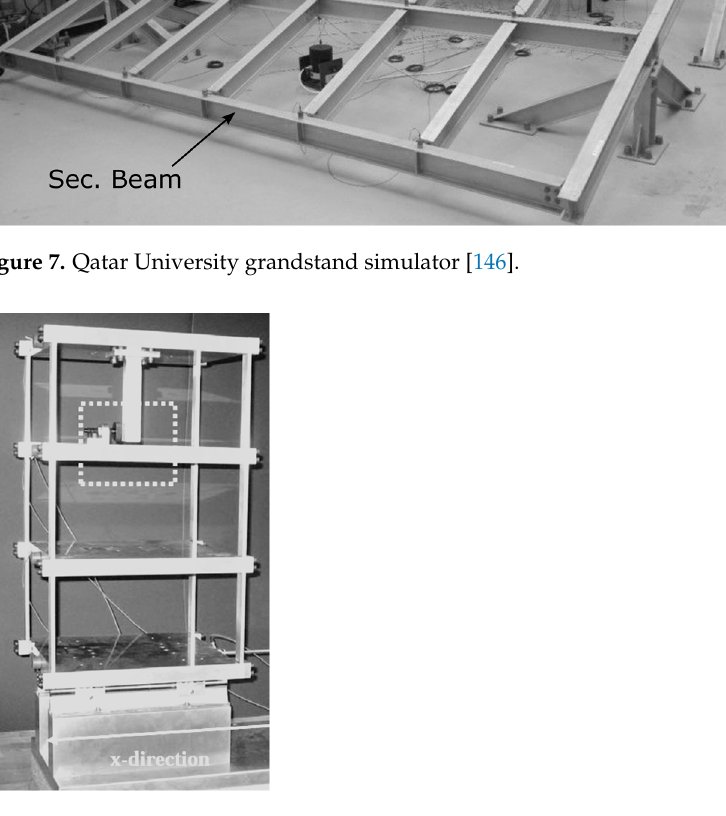
Figure 8. Los Alamos National three-story frame structure [148].